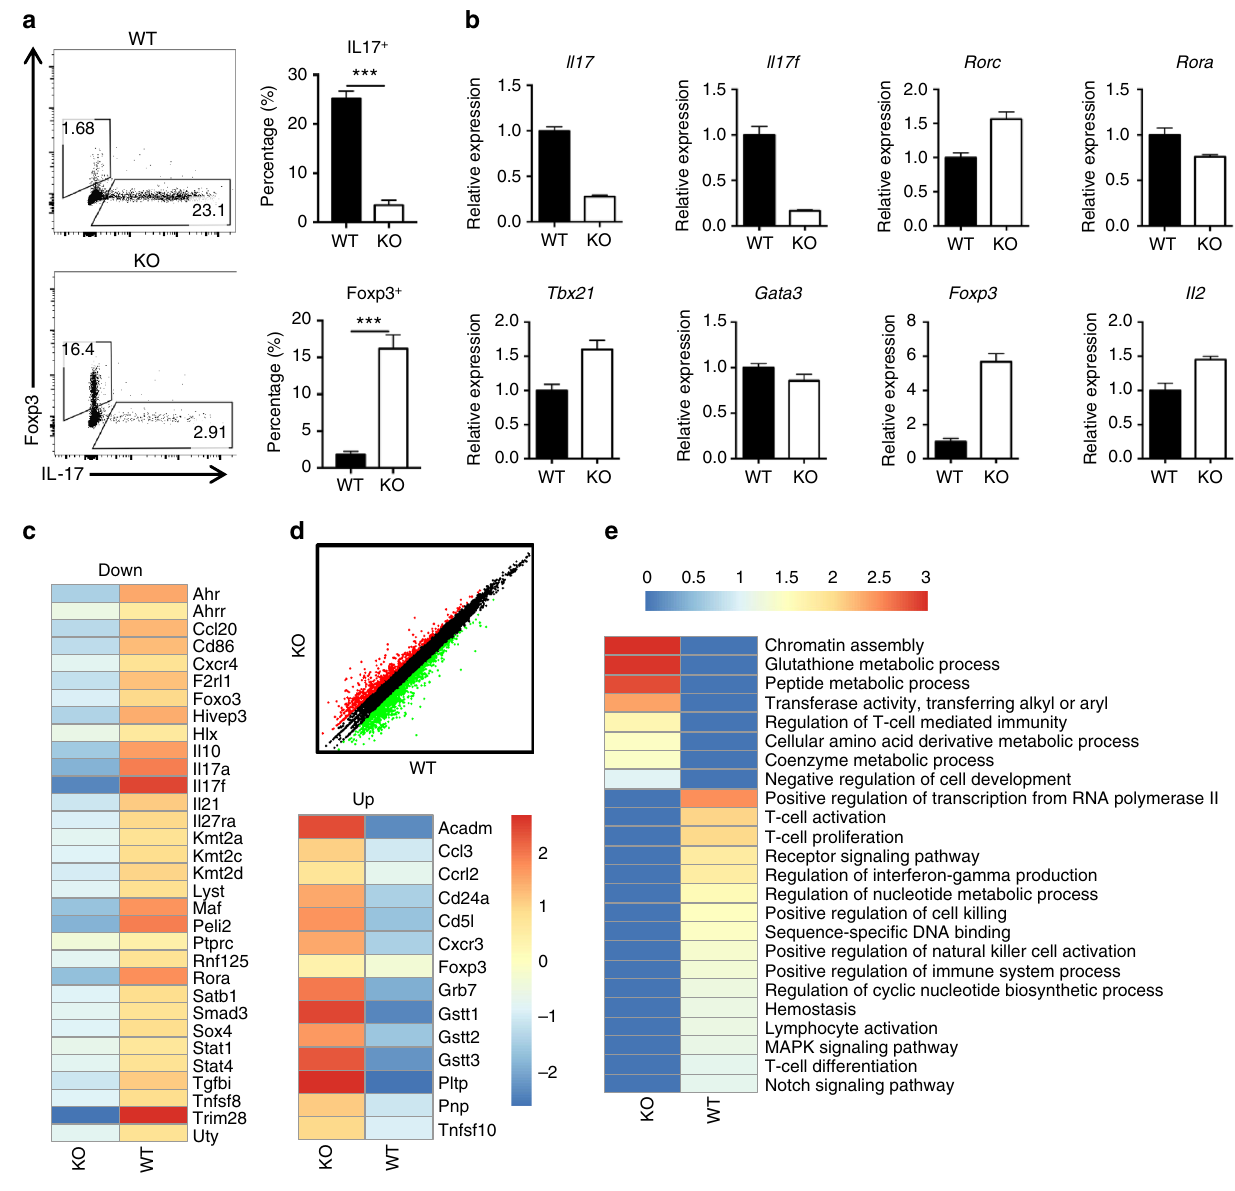
Fig. 2 TRIM28 KO CD4 + T cells were defective in Th17 differentiation. WT or TRIM28-de fi cient naive CD4 + T cells were polarized into Th17 cells in the presence of TGF- β and IL-6 for 3 days, and then re-stimulated for intracellular staining and mRNA analysis. a Intracellular staining results and their statistics (Student ’ s t test; ns not signi fi cant; * p < 0.05, ** p < 0.01, *** p < 0.005). b The relative mRNA expression levels as determined by real-time PCR assay. c , d Heatmap (left and lower right) and scatter diagram (upper right) of RNA-seq results obtained from WT and TRIM28 KO Th17 cells (anti-CD3 re-stimulated); e Heatmap of pathway analysis from RNA-seq data obtained from WT and TRIM28 KO Th17 cells. All error bars represent SDs. a , b Representative data of three independent